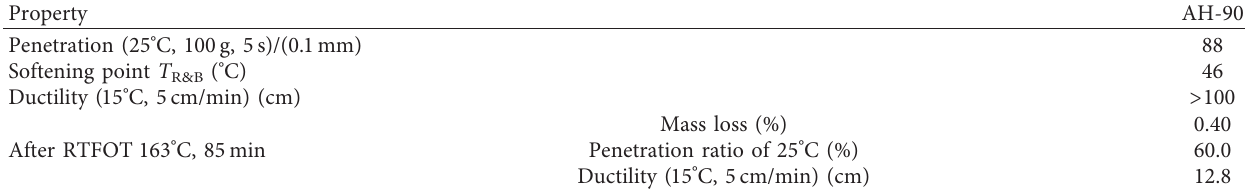
Table 1: Physical properties of base asphalt.